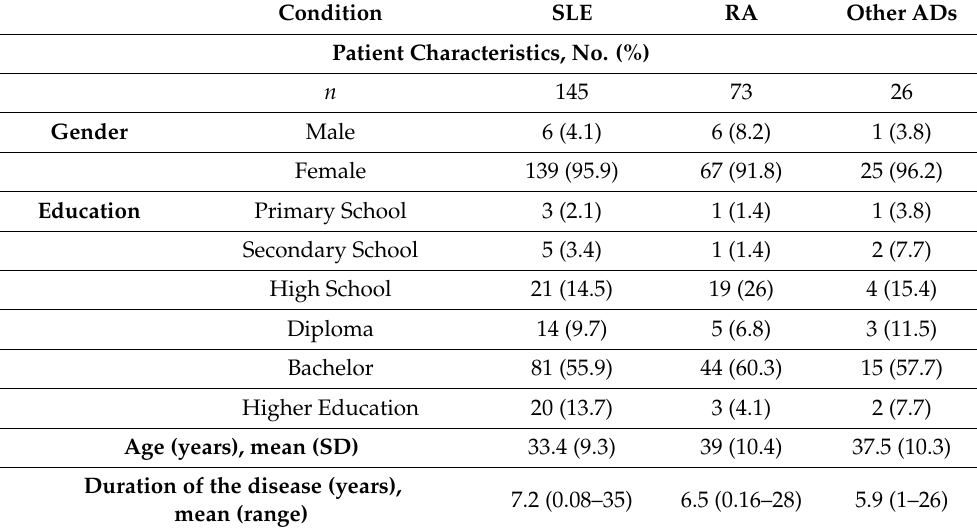
Table 2. Demographics and patients’ characteristics ( n = 244).